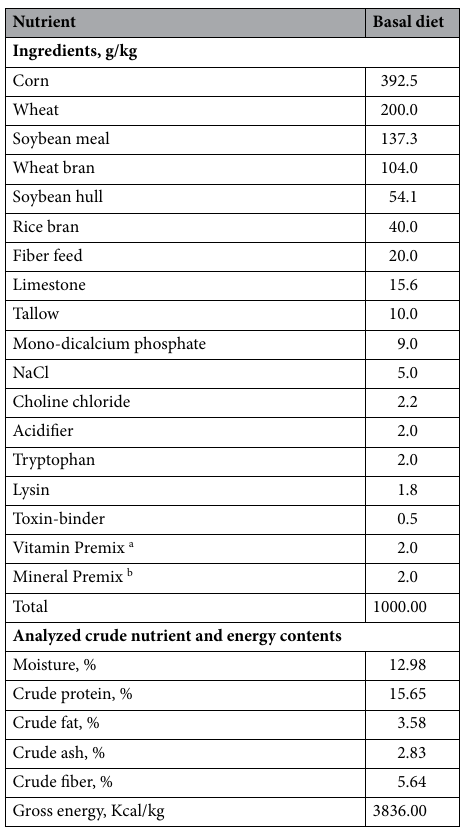
black pigs following a 3-month-long experimental study. At the start of the study, eight 4-month-old pigs were randomly recruited into 2 groups (n = 4, in each group). Each group was subjected to a separate diet: either a basal diet (Control group) or synbiotics-supplemented diet (Treatment group). The experimental animals had similar mean body weight both at the start (32.8 ± 4.5 and 32.6 ± 2.5 kg, respectively) and at the end of the experiment (60.4 ± 1.3 and 56.5.x ± 6.8 kg, respectively). All animals were monitored daily by caretakers and the investigating team to ensure their health and welfare. During health monitoring, the care takers observed the animals for signs of GIT conditions (reduced appetite, diarrhea, constipation, rectal prolapses), urogenital tract conditions (discoloration in urine, vaginal discharge) as well as respiratory conditions (coughing, sneezing, rhinitis). All animals remained healthy throughout the study. The formulation of basal diet is presented in Table 1. The treatment group was allowed ad libitum access to a basal diet supplemented with a synbiotic containing Lactobacillus buchneri NLRI-1201 (1.2 × 10 8 colony forming units (cfu)/kg feed), L. plantarum NLRI-101 (1.6 × 10 8 cfu/kg feed), L. casei DK128 (1.4 × 10 8 cfu/kg feed), and